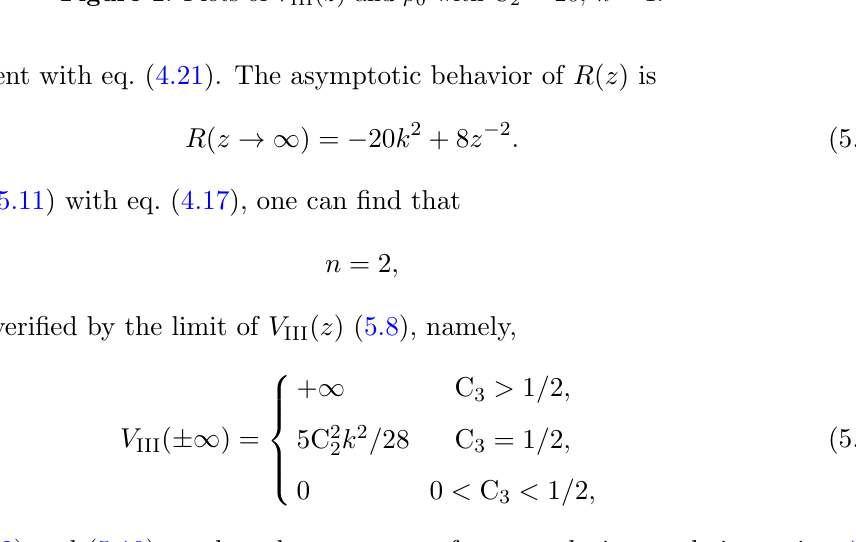
Figure 1 . Plots of V III ( z ) and ~ (cid:26) 0 with C 2 = 20 ; k = 1